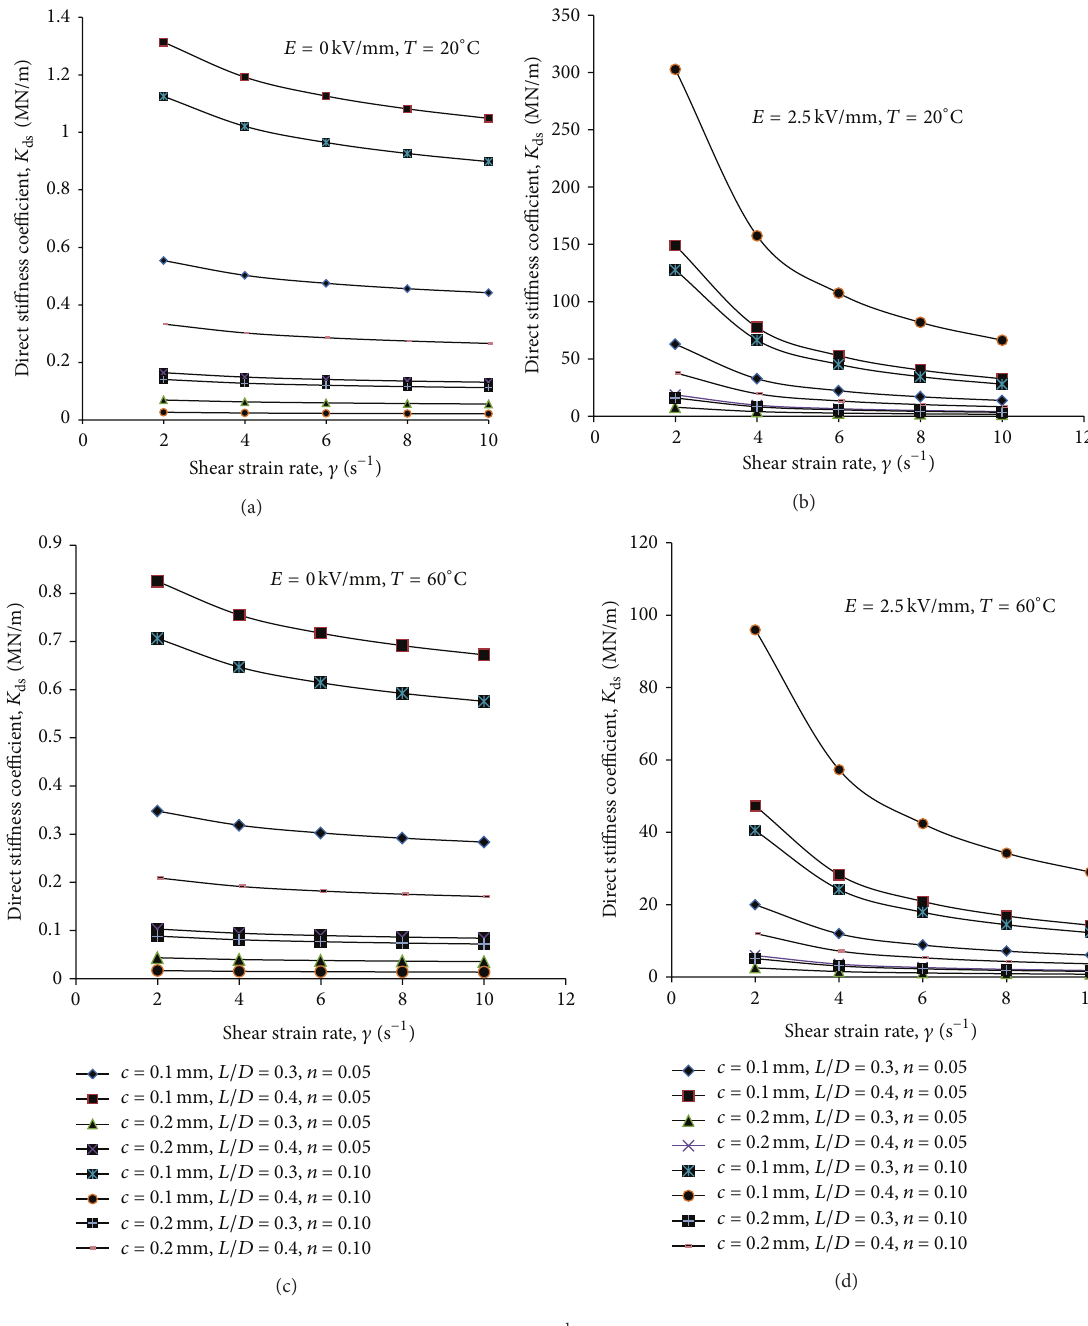
Figure 8: Direct stiffness coefficient, MN/m versus shear strain rate, s −1 , for (a) 𝐸 = 0 kV/mm, 𝑇 = 20 ∘ C; (b) 𝐸 = 2.5 kV/mm, 𝑇 = 20 ∘ C; (c) 𝐸 = 0 kV/mm, 𝑇 = 60 ∘ C; and (d) 𝐸 = 2.5 kV/mm, 𝑇 = 60 ∘ C. However, it should be noticed that the viscosity increases by many orders under the action of the